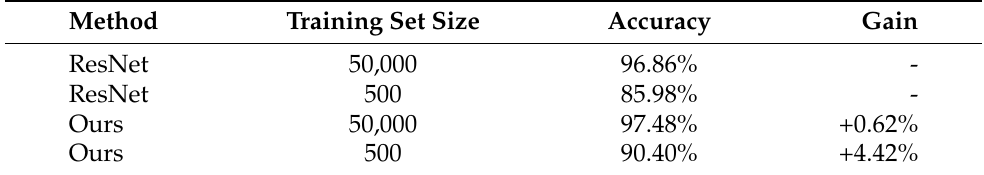
Table 3. Model accuracy when the number of training set samples drops